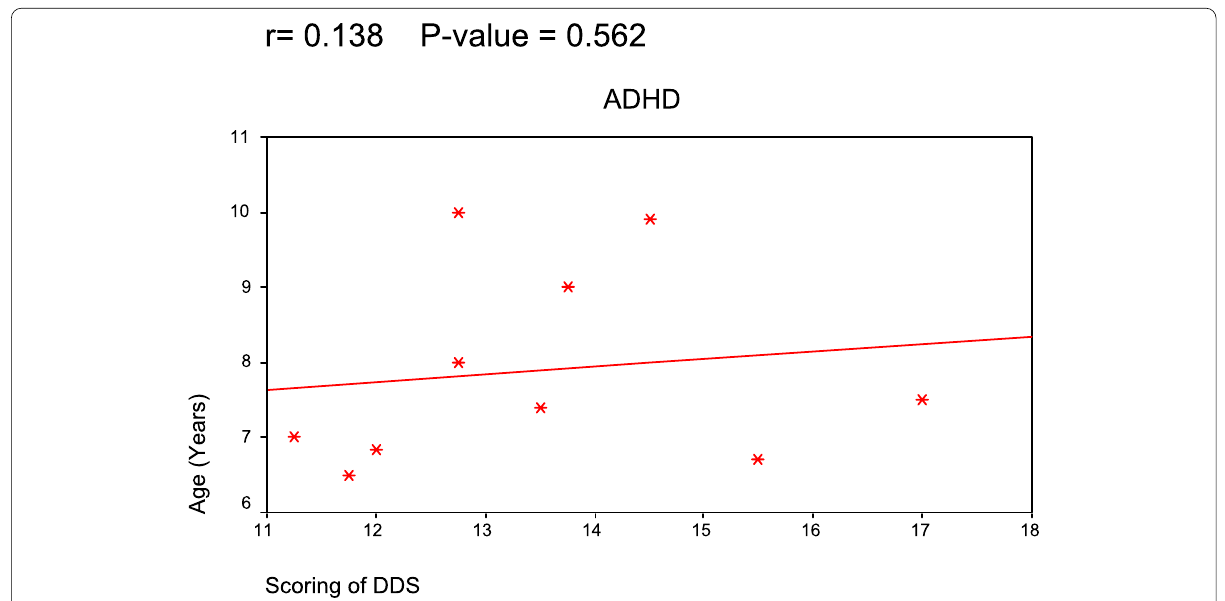
Fig. 1 Correlation between age and total score of DDS in ADHD